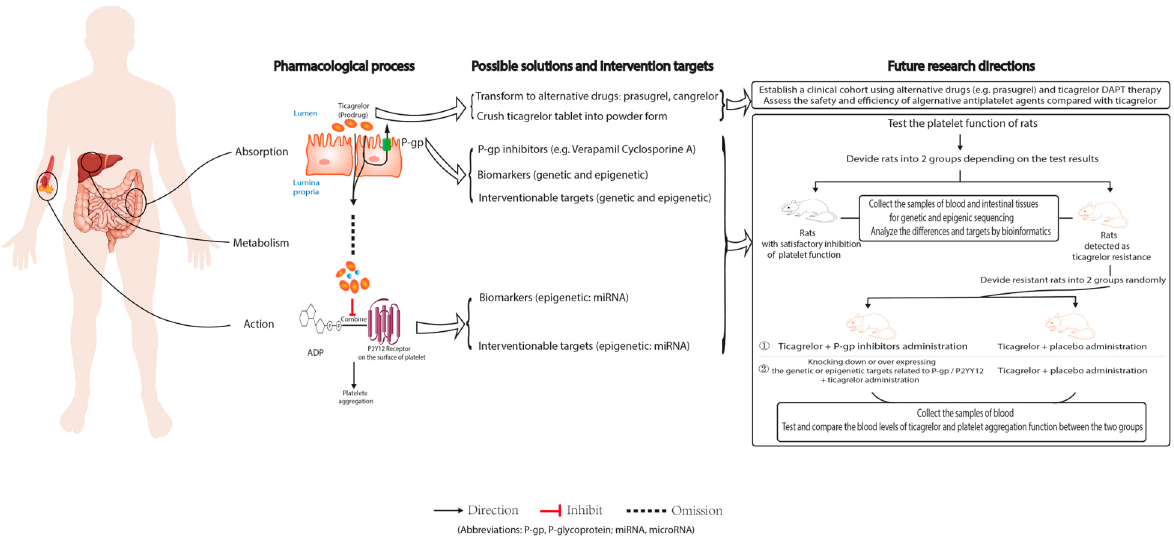
Figure 3. Possible intervention targets of, and future research directions for, ticagrelor resistance.